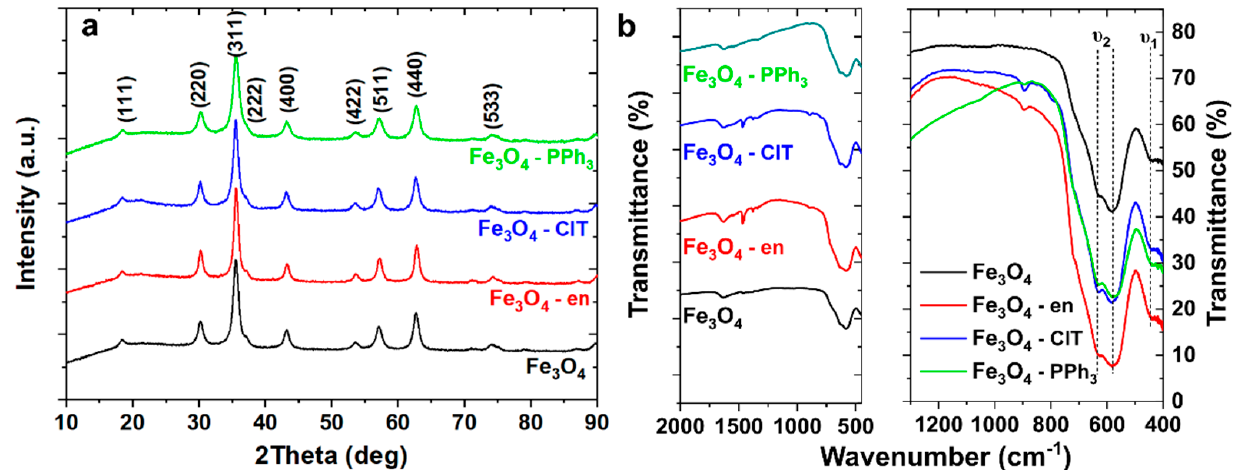
Figure 1. Structural analysis of magnetite nanoparticles: ( a ) X-ray diffraction patterns of magnetite nanoparticles synthesized without (Fe 3 O 4 ) and with the presence of ethylenediamine (Fe 3 O 4 –en), chloramine T (Fe 3 O 4 –ClT), and triphenylphosphine (Fe 3 O 4 –PPh 3 ); ( b ) Fourier-transform infrared spectra of the same samples. The left panel presents the spectra in a wide frequency range, and the right panel shows the spectra in a narrow frequency range, in which characteristic vibrations from Fe–O bonds ( υ 1 and υ 2 ) occurred. Table 1. The average crystallite size ( D H-W ), intrinsic strain ( ε ), average particle size ( D av ), and characteristic for Fe–O bonds vibrations ( υ 1 , υ 2 , and υ 2’ ).